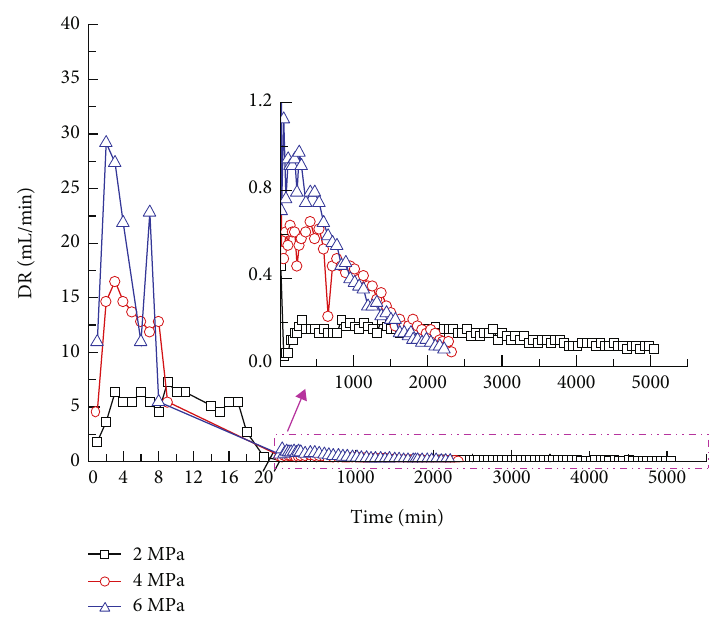
Figure 5: DR under di ff erent water injection pressures.